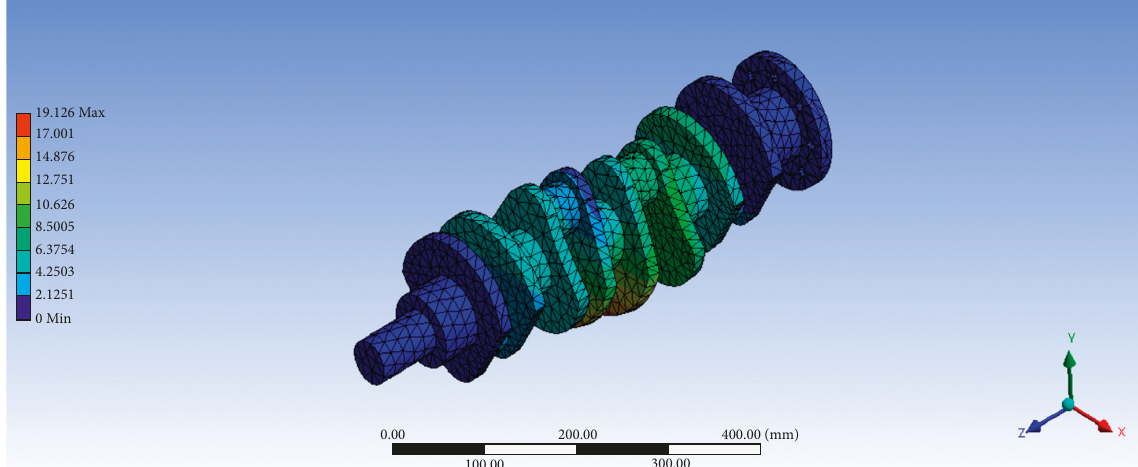
Figure 6: Deformation of stainless-steel crankshaft at the second mode of vibration.